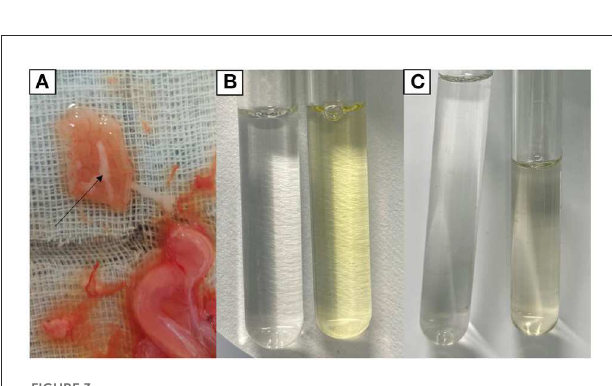
FIGURE3 Chemical findings of uterine secretions. (A) Uterine secretions. (B) Control group (left) and model group (right). (C) Control group (left) and treatment group